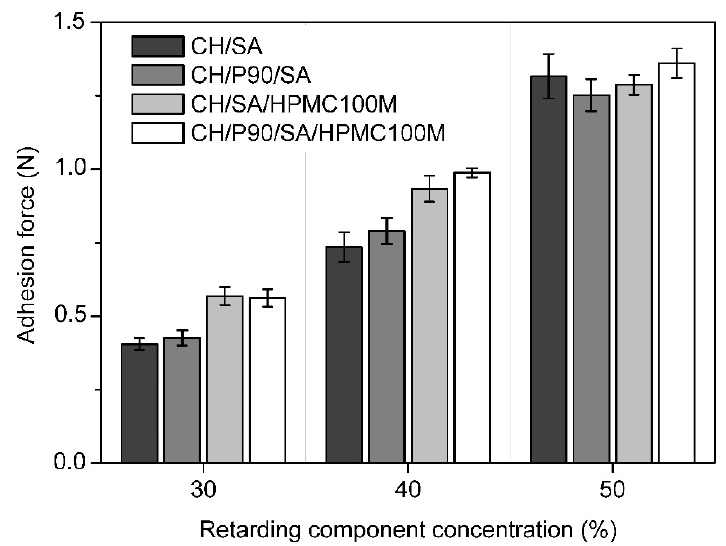
Figure 3. Mucoadhesive properties of the chitosan − based matrix tablets treated with PBS pH 6.8. CH − chitosan; P90 − Prosolv SMCC 90; SA − sodium alginate; HPMC100M − Methocel K100M. Data are 6.8. CH—chitosan; P90—Prosolv SMCC 90; SA—sodium alginate; HPMC100M—Methocel K100M. expressed as average values ± SD of five tests. Data are expressed as average values ± SD of five